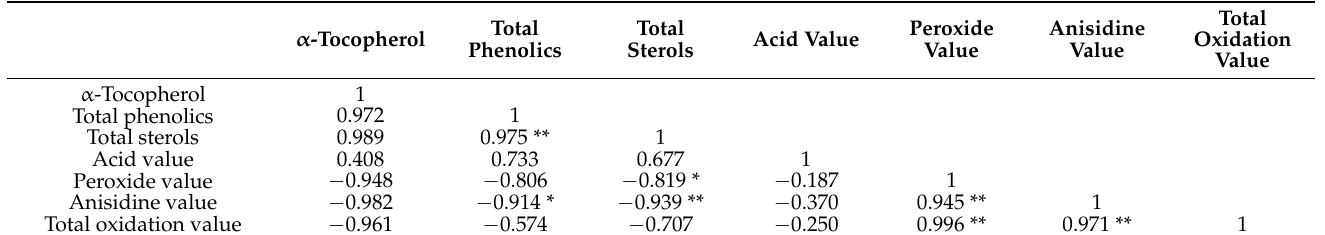
Table 7. Correlation analysis of physical and chemical quality of SSO samples.